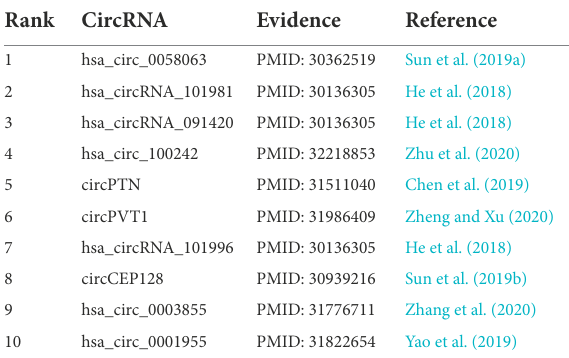
TABLE 1 Case study based on microRNA